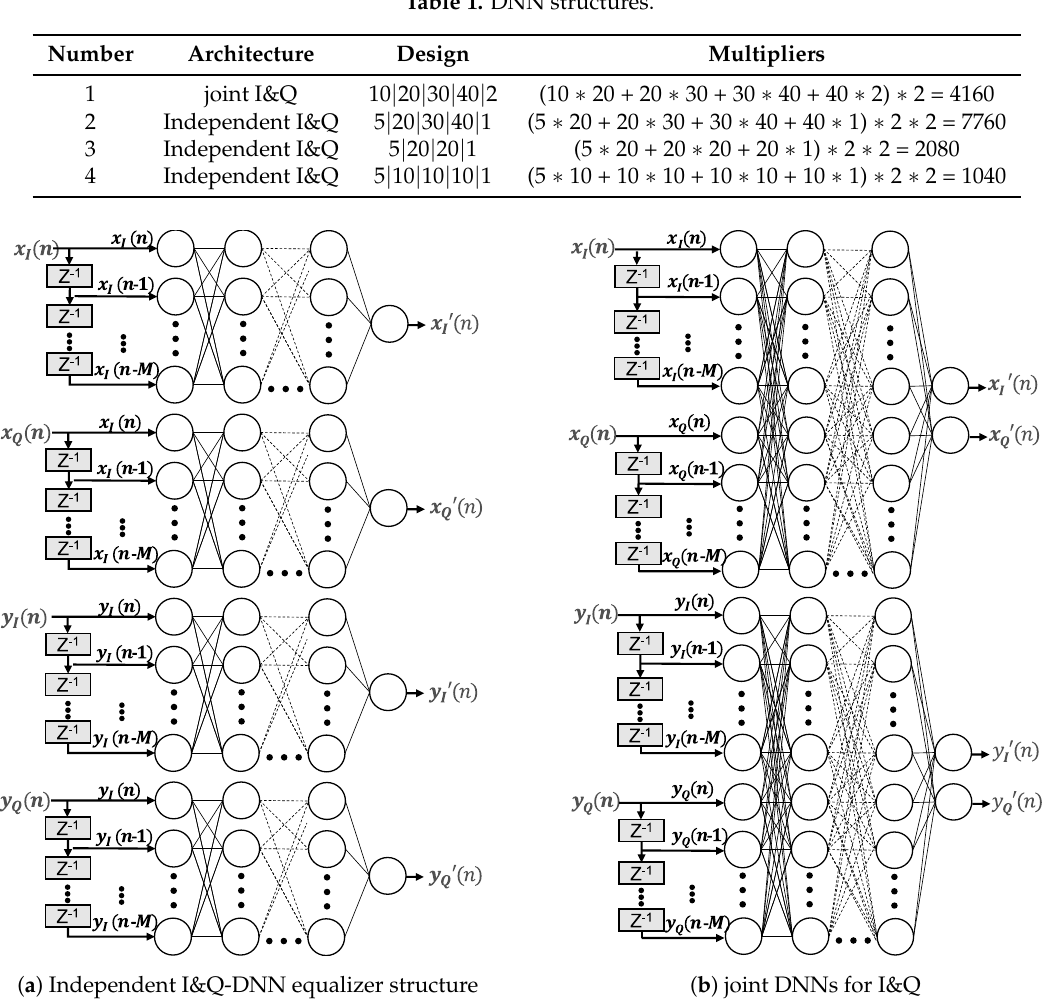
Table 1. DNN structures.